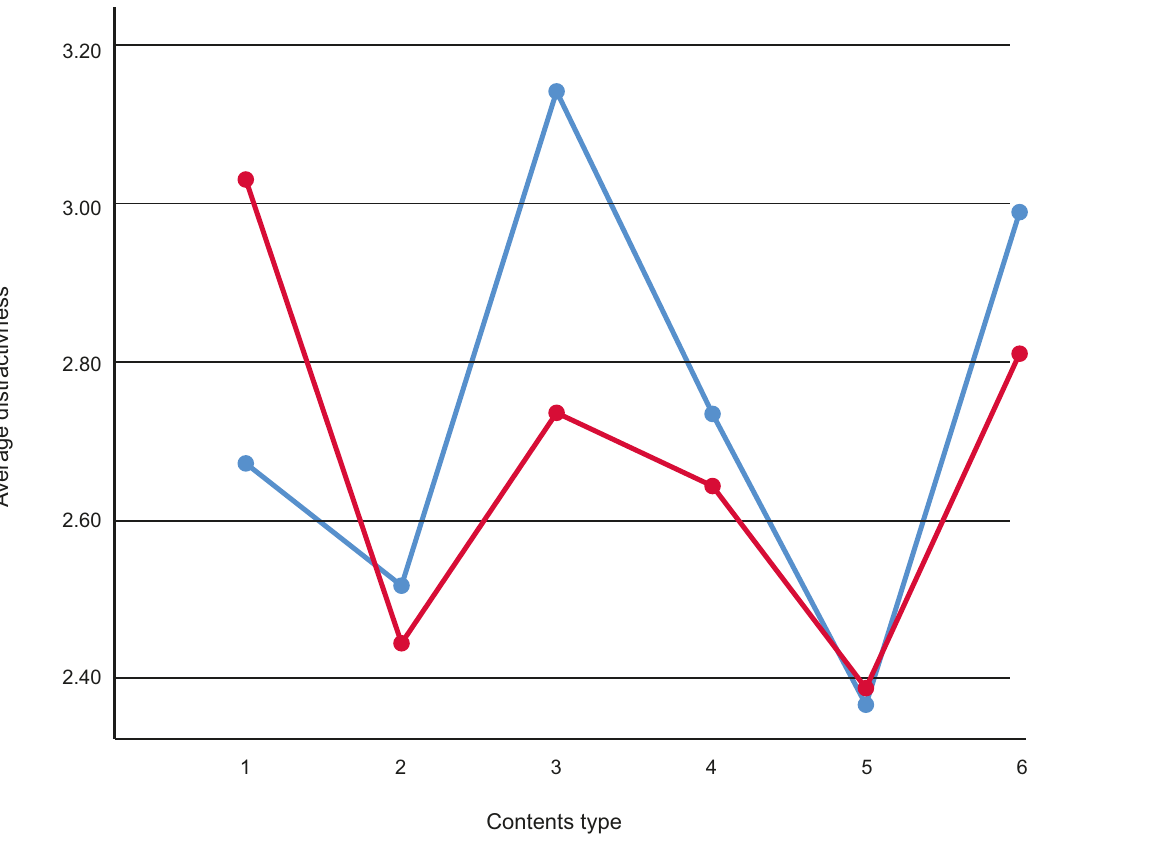
Fig 2. Interaction effect of content type and gender. Types of contents: 1- Sexual, 2- Positive, 3- Negative, 4- Humorous, 5- Sales offers, 6- Intriguing.